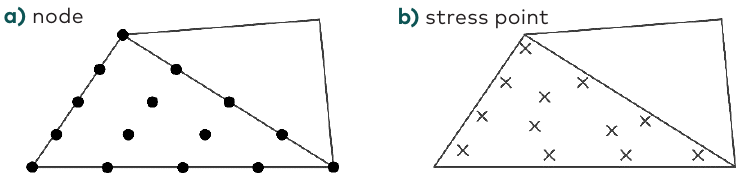
Figure 2. 15-node triangular elements (Brinkgreve,